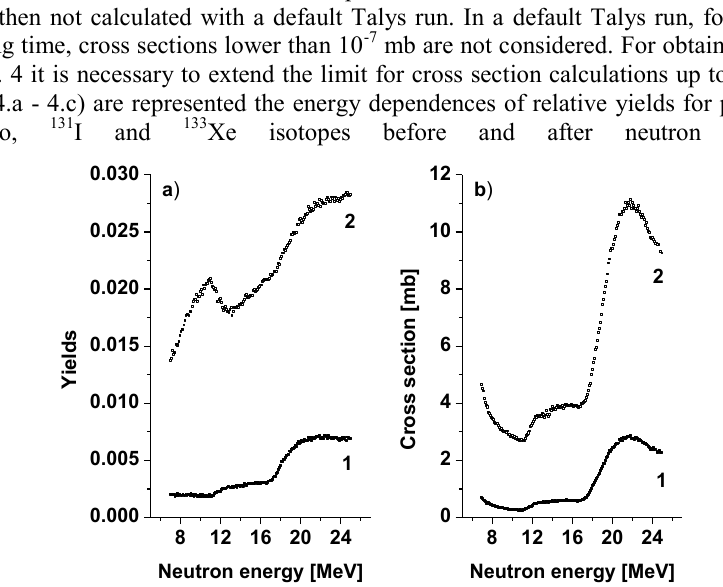
Fig. 5. 135 Xe production. Energy dependence of: a) Relative yields; b) Cross section; Neutron emission: 1 - Pre; 2 -